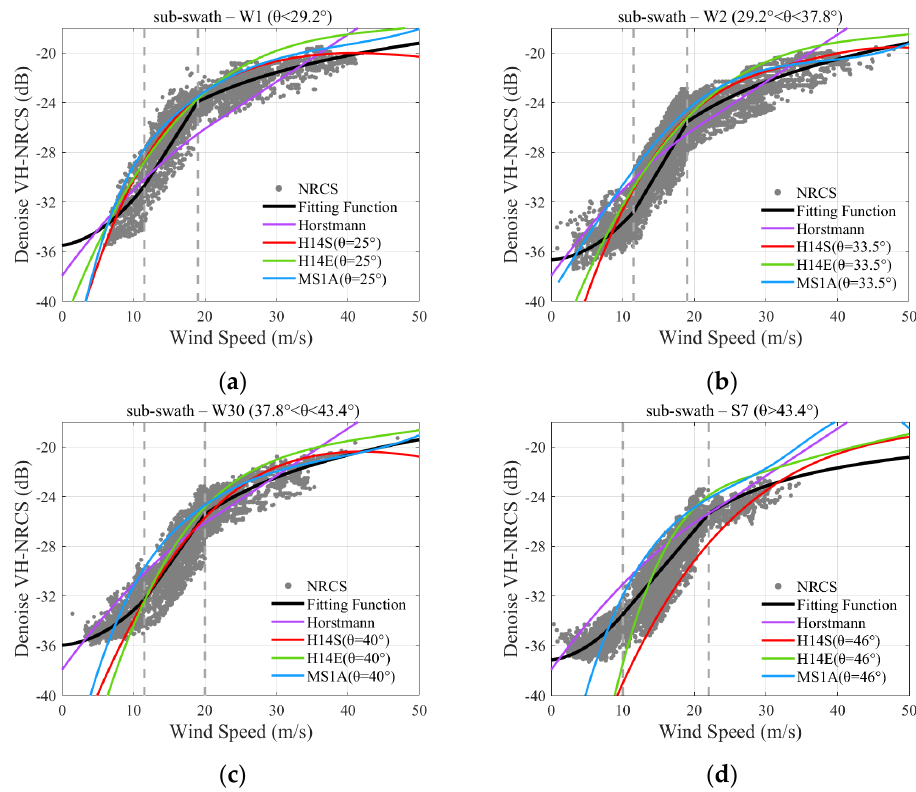
Figure 9. Relationship between the cross-polarized NRCS and the wind speed on the sub-swaths ( a ) W1, ( b ) W2, ( c ) W30, and ( d ) S7. The black lines denote the fitting curves.